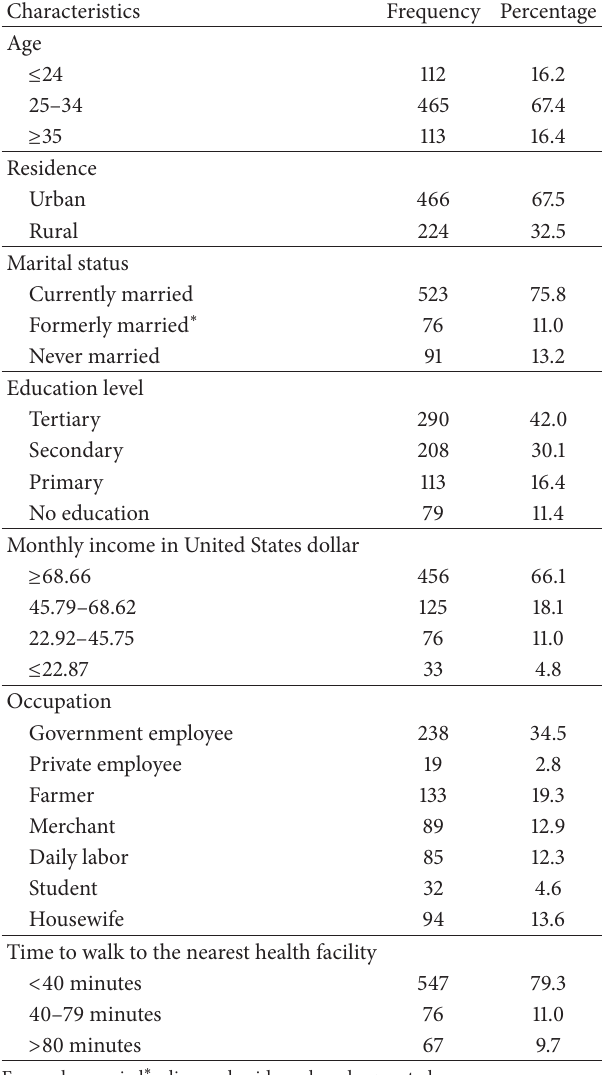
Table 1: Sociodemographic and economic characteristics of partic- ipants ( 𝑛 = 690